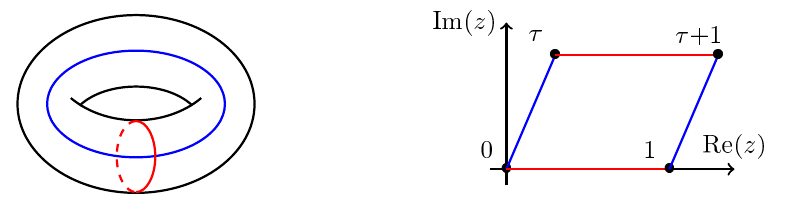
Figure 1 . Parameterization of the torus through the lattice C / ( Z + τ Z ) with an identification of points z with their translates z +1 and z + τ along the A - and B